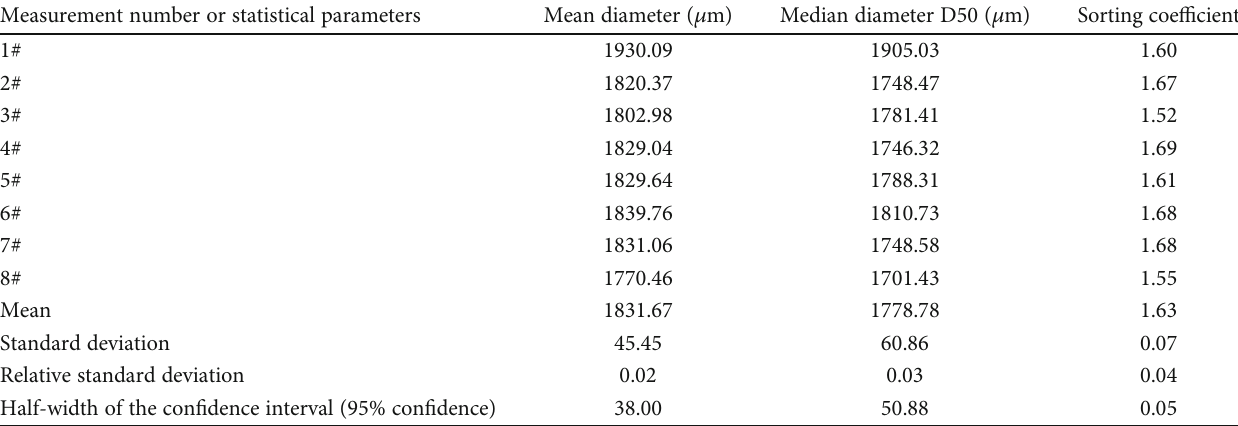
Table 1: Statistical parameters (mean, standard deviation, relative standard deviation, and half-width of the 95% con fi dence interval) of PSD characteristics parameters of 8 times repeated experiments ( mass = 5 g).